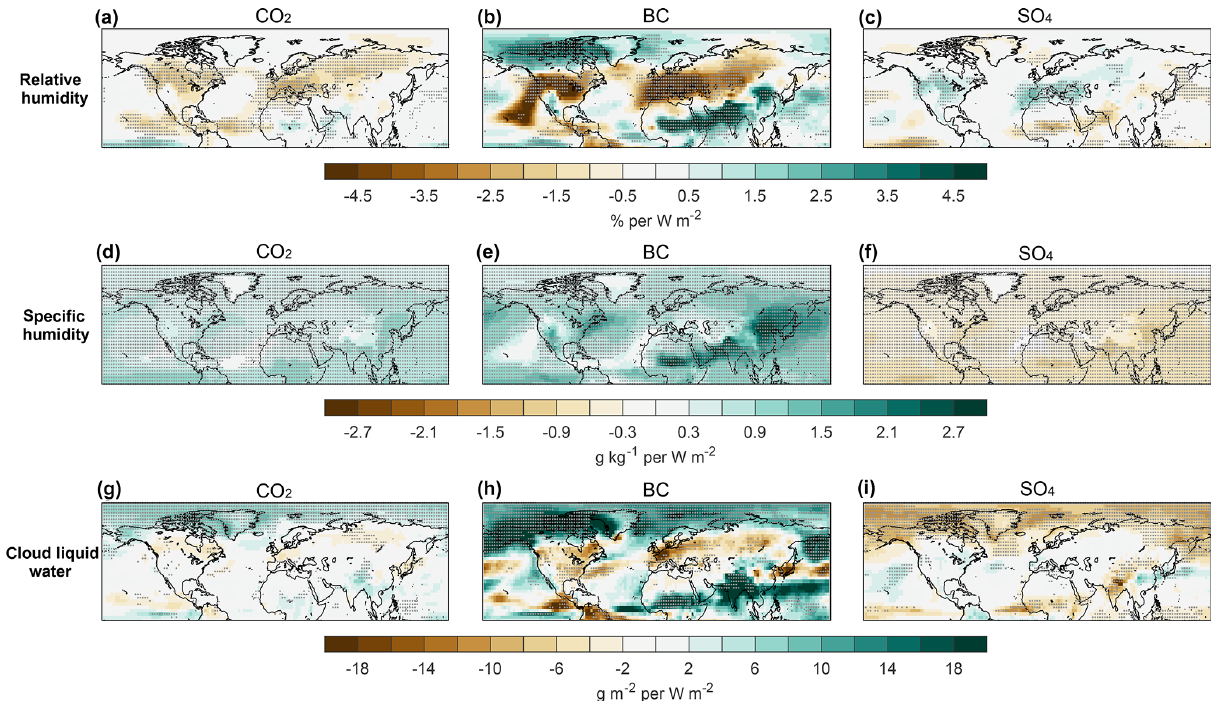
Figure 4. Same as Fig. 2, but for humidity at 850hPa.